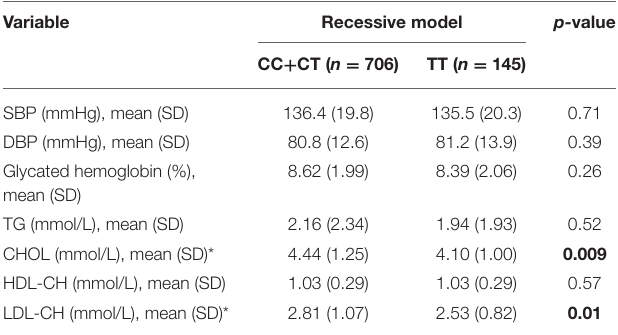
TABLE 4 | Relationship between rs1800504 and blood lipids in T2DM patients.